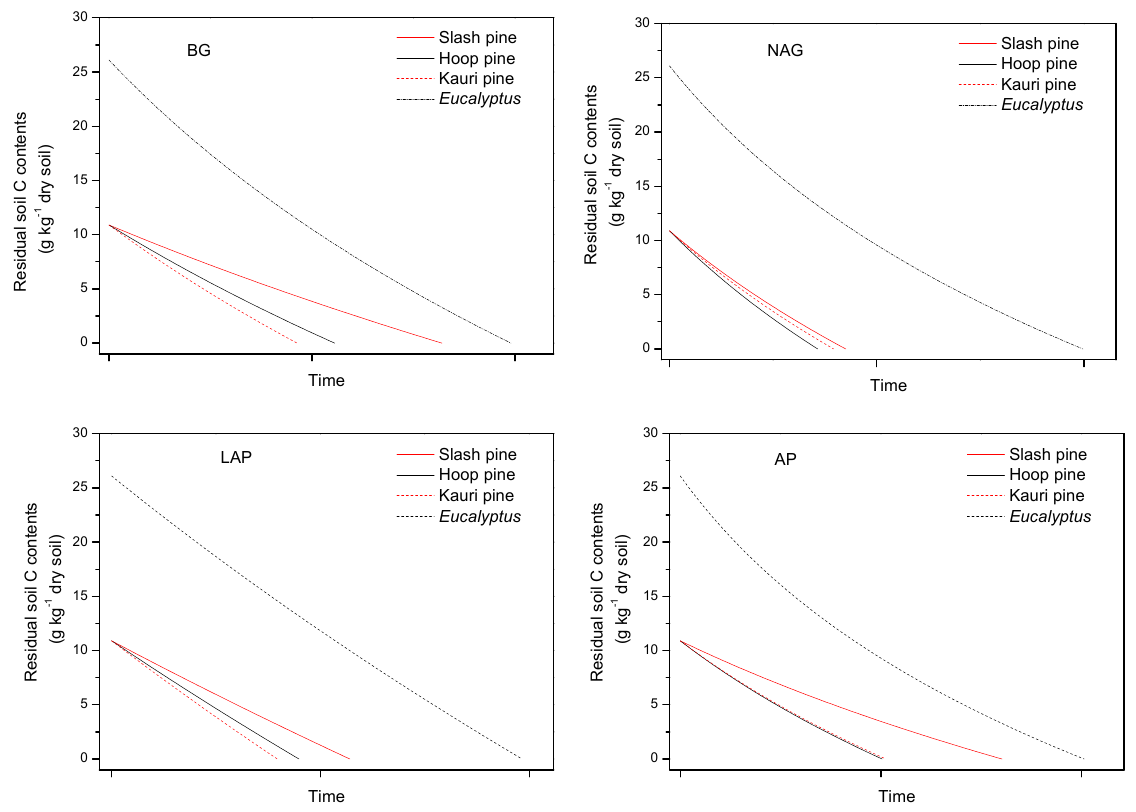
Figure 2. Residual soil C contents under different tree species across time for β -glucosidase (BG), N -acetylglucosaminidase (NAG), leucine aminopeptidase (LAP) and acid phosphatase (AP) at 25 ◦ C. The total soil C decomposition over time was calculated via Eq. (5) and the residual soil C contents over time was compared for different enzyme activities among the tree species.